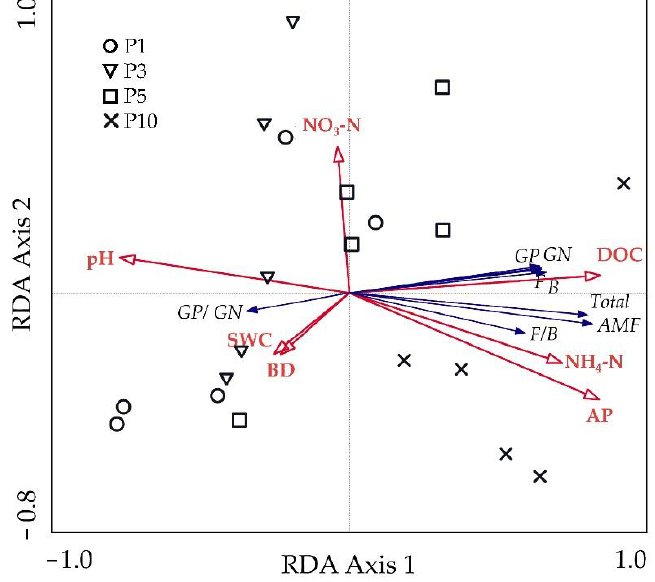
Figure 5. Redundancy analysis (RDA) results of PLFA profiles for the soil samples used seven microbial PLFAs and seven environmental variables in 0–10-cm soil. (P1, P3, P5, P10 represent soil microbial PLFAs in pomegranate plantation of 1, 3, 5, 10 years, respectively; DOC: dissolved organic carbon; AP: available phosphorus; BD: bulk density; SWC: soil water content; Total: total PLFAs; B: bacterial PLFAs; F: fungal PLFAs; F/B: the ratio of fungal PLFAs to bacterial PLFAs; GP: Gram- positive bacterial PLFAs; GN: Gram-negative bacterial PLFAs; GP/GN: the ratio of Gram-positive bacterial PLFAs to Gram-negative bacterial PLFAs; AMF: arbuscular mycorrhizal fungal PLFAs).